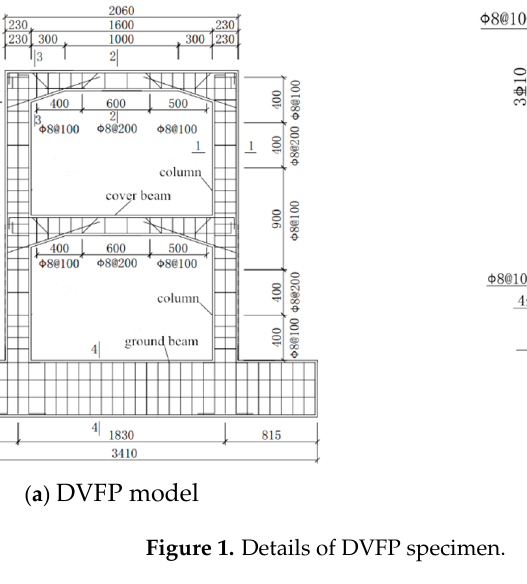
Table 2. Material properties of CFRP and mucilage.